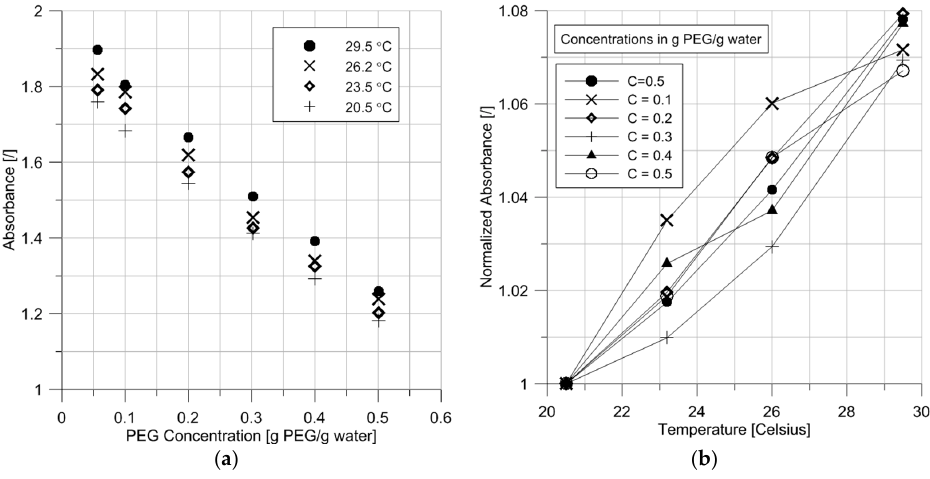
Figure 7. ( a ) Evolution of absorbance of PEG 20,000 solutions as a function of PEG concentration for different temperatures; ( b ) Evolution of the normalized absorbance, defined as the absorbance at temperature T over the absorbance at 20.5 degrees Celsius, with temperature.